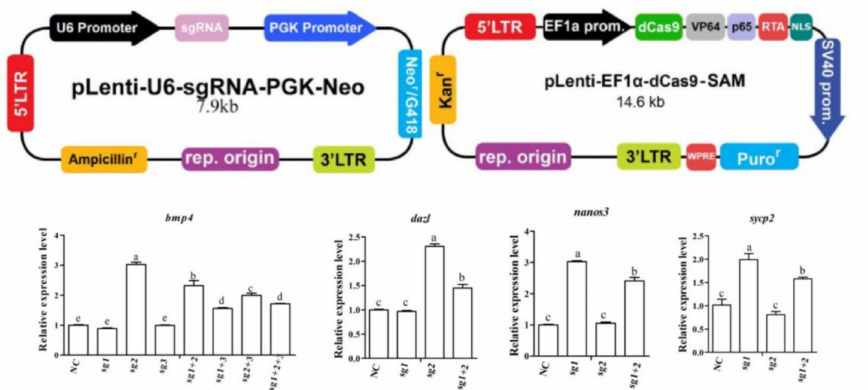
Figure 4. The expression location of Bmp4, Dazl, Nanos3 and Sycp2 in sheep Leydig cells. To locate the expression of Bmp4, Dazl, Nanos3 and Sycp2 in sheep Leydig cells, immunofluorescence was carried out. DAPI indicated the nuclear staining, and the results were photographed under a laser scanning confocal microscope at a magnification of 40 × .